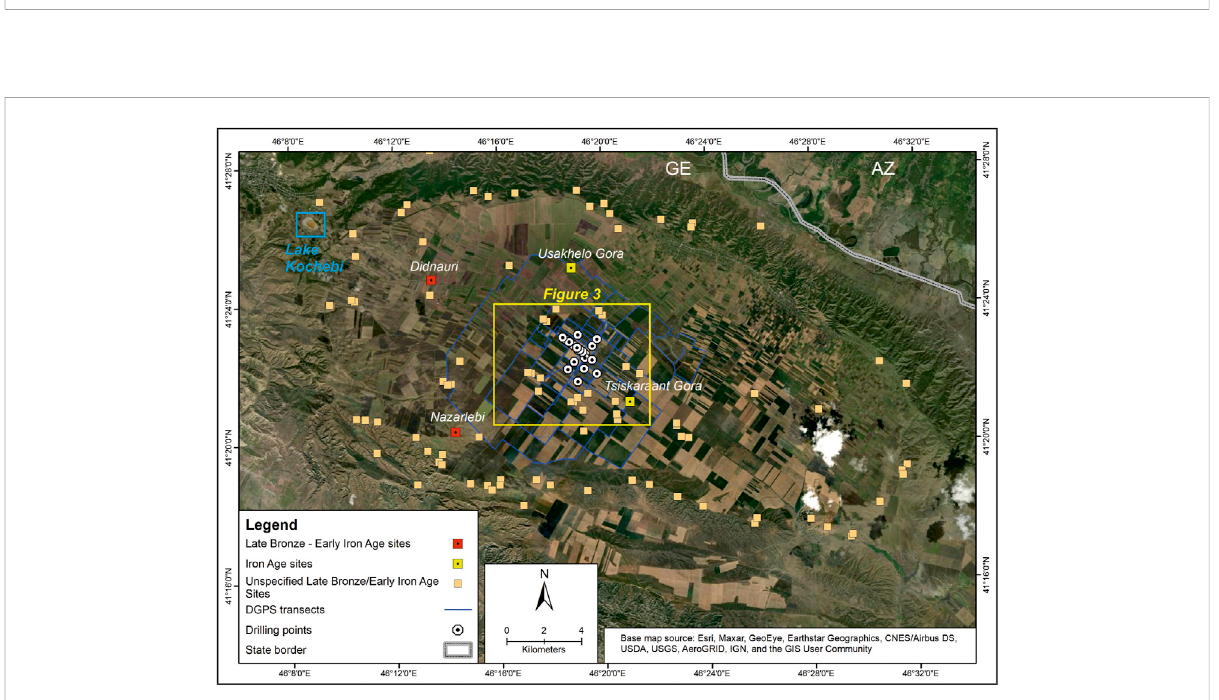
FIGURE 2 The Shiraki Plain with Late Bronze/Early Iron Age archaeological sites (Varazashvili and Pitskhelauri, 2011) and the core drillings and DGPS transectsofthisstudy.TheareashowninFigure 3isindicatedwith ayellowrectangle, and LakeKochebiwestoftheplainwithabluerectangle[GE= Georgia, AZ =